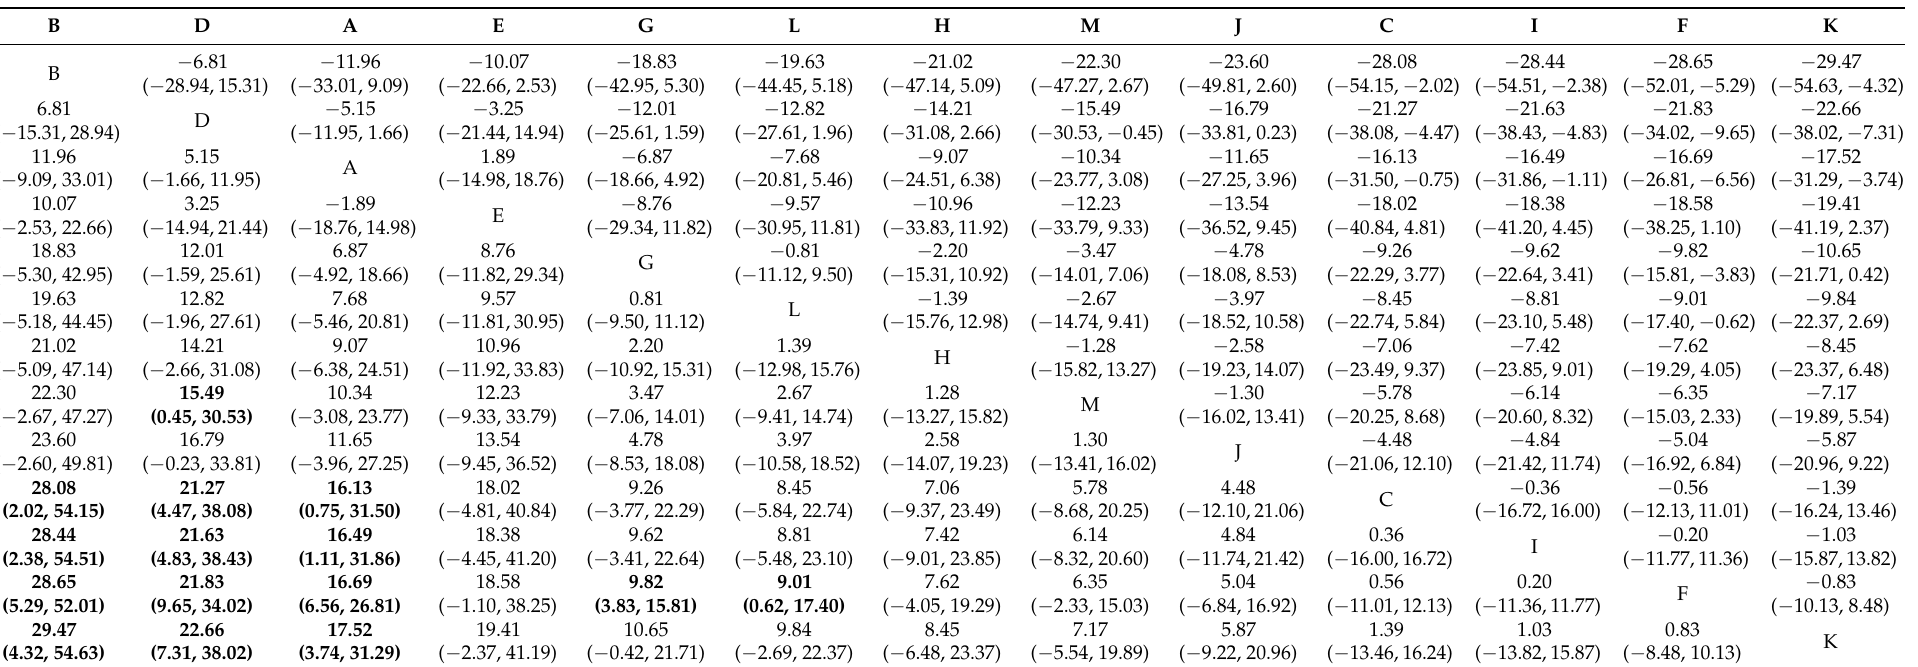
Table 6. Network analysis results of the denomination